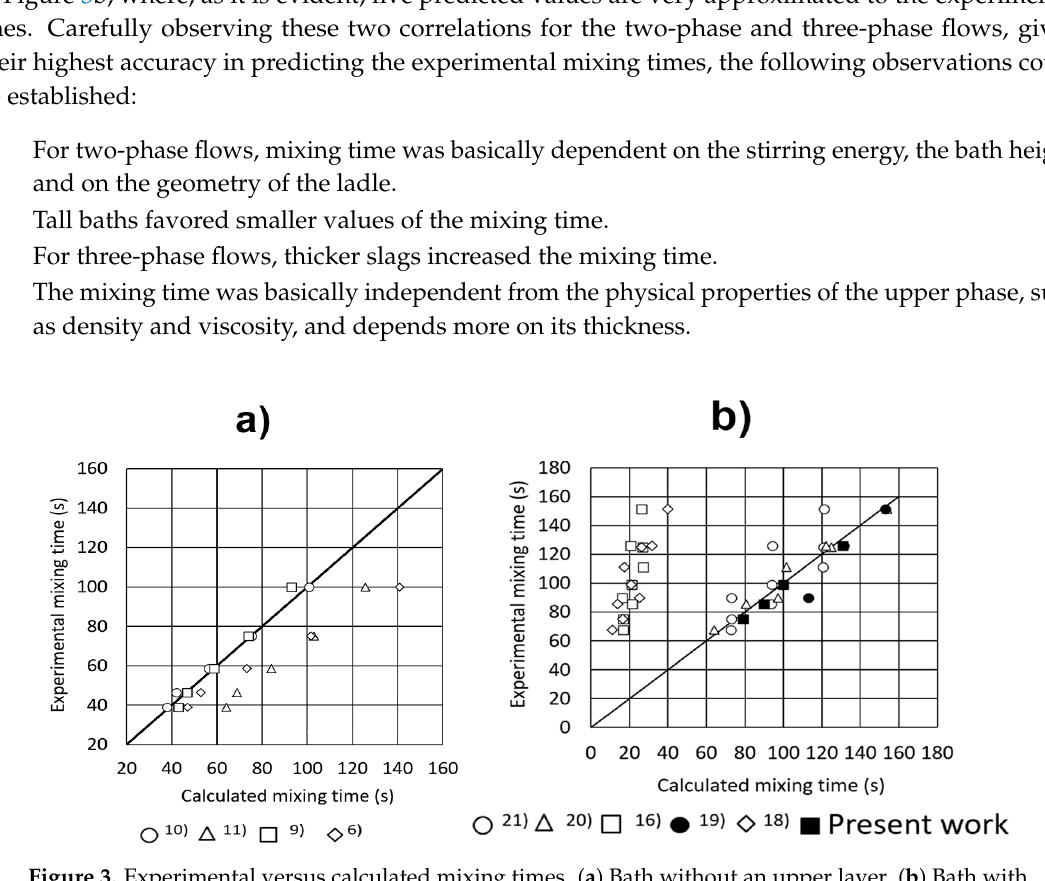
Figure 3. Experimental versus calculated mixing times. ( a ) Bath without an upper layer. ( b ) Bath with an upper layer.